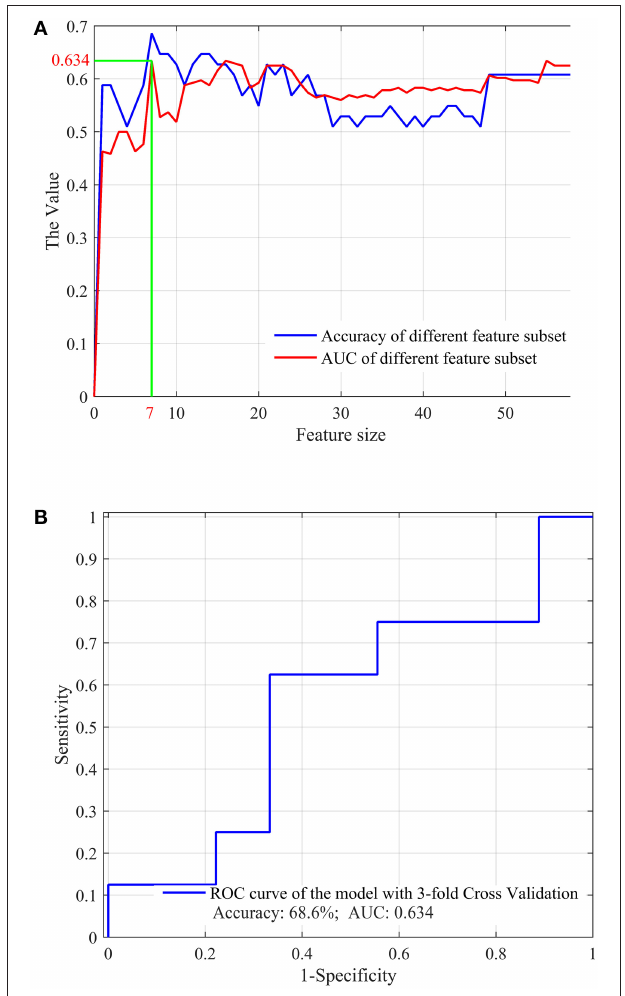
FIGURE 4 | The optimal feature subset selected from the significant radiomics features and the clinical factors (A) and the overall performance (B) for the prediction of the re-positive